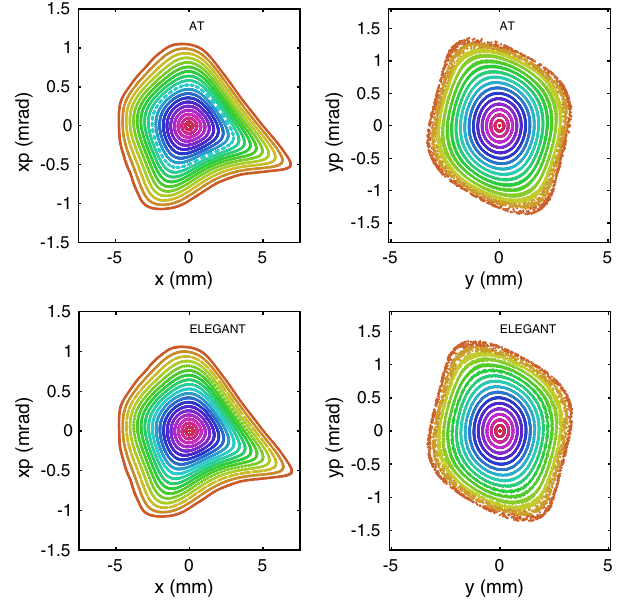
FIG. 6. Comparison of Hamiltonian contours in the horizontal phase space by tracking simulation for ELEGANT and AT . β x ¼ 5 . 20 m and β ¼ 2 . 39 m at the launching point. Rf cavity is y turned off in the model. Top: AT ; bottom: ELEGANT